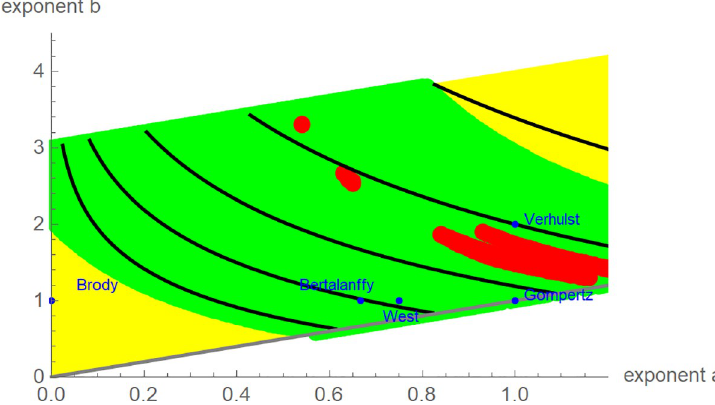
Fig 5. Exponent-pairs of named models (blue), exponent-pairs of models with RL > 99.5% for 66 data (red), exponent-pairs of models with RL > 95% for 80 data (green), remaining exponent-pairs of the search grid (yellow), diagonal a = b (grey) and contour lines (thick and black) of the ratios 0.2, 0.3, ... , 0.6 (from left to right), using Eq (2) for the